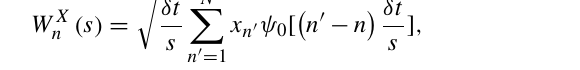
Figure 1. (a) The QBO index and (b) the corresponding wavelet power spectrum. Contours enclose regions of 5% statistical point- wise significance (Torrence and Compo, 1998). Light shading rep- resents the cone of influence; i.e., the region in which edge effects cannot be